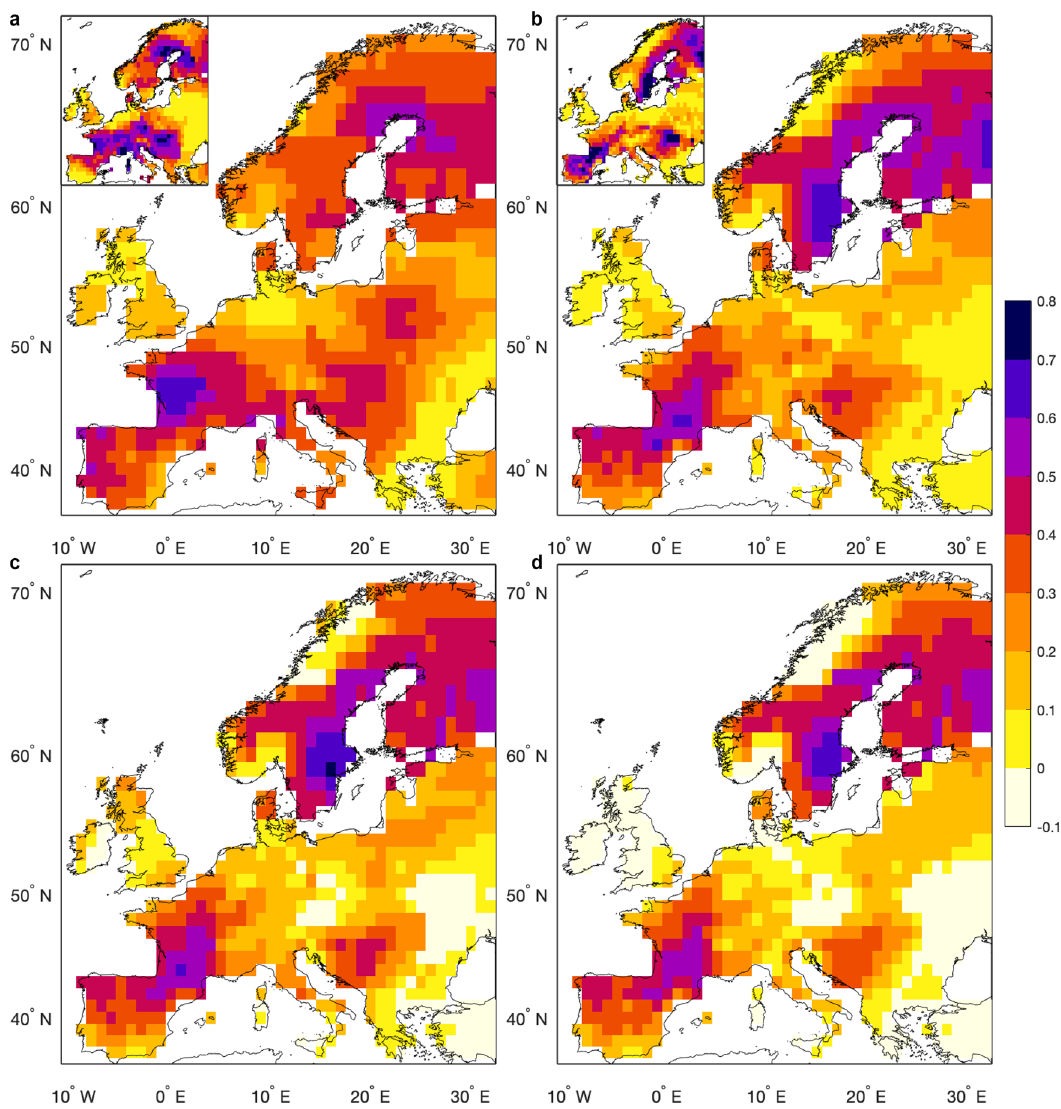
Fig. 2 Spatial reconstruction statistics. Calibration and veri fi cation statistics for the SPEI reconstruction. Explained variance ( R 2 ) of a the calibration period (median CRSQ = 0.31) and b the veri fi cation period (median VRSQ = 0.22) on interannual and decadal timescales (insets) using a 5-year moving average fi lter. c Reduction of error of the calibration period (median RE = 0.20). d Coef fi cient of ef fi ciency of the veri fi cation period (median CE =